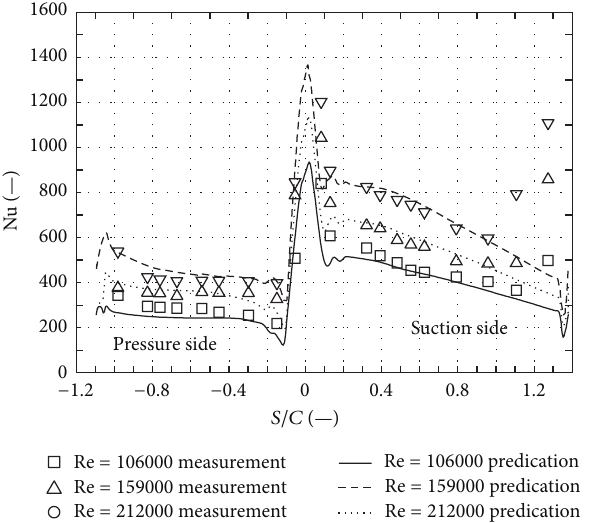
Figure 15: Nusselt number distribution at different locations through blade height, Re = 212000.